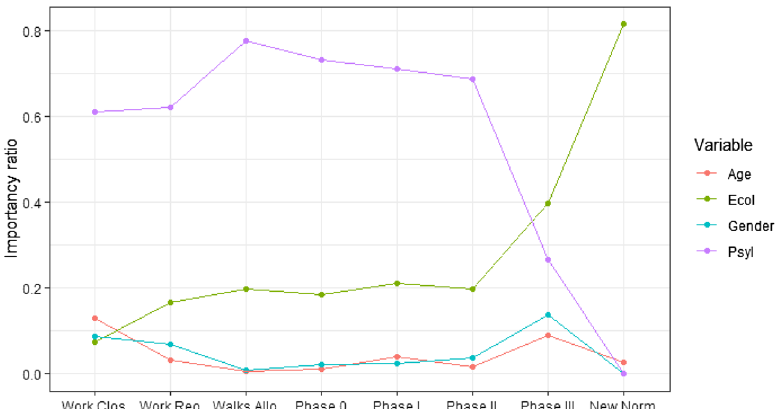
Figure 2. Evolution of the variable importance over time, according to the pattern extraction